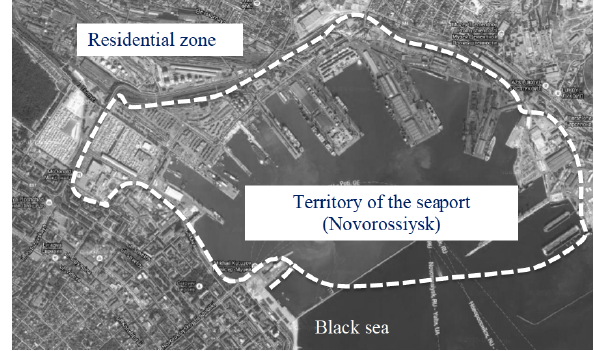
Figure 3: Location of one of the major seaport in residential zone, on example of the Novorossiysk